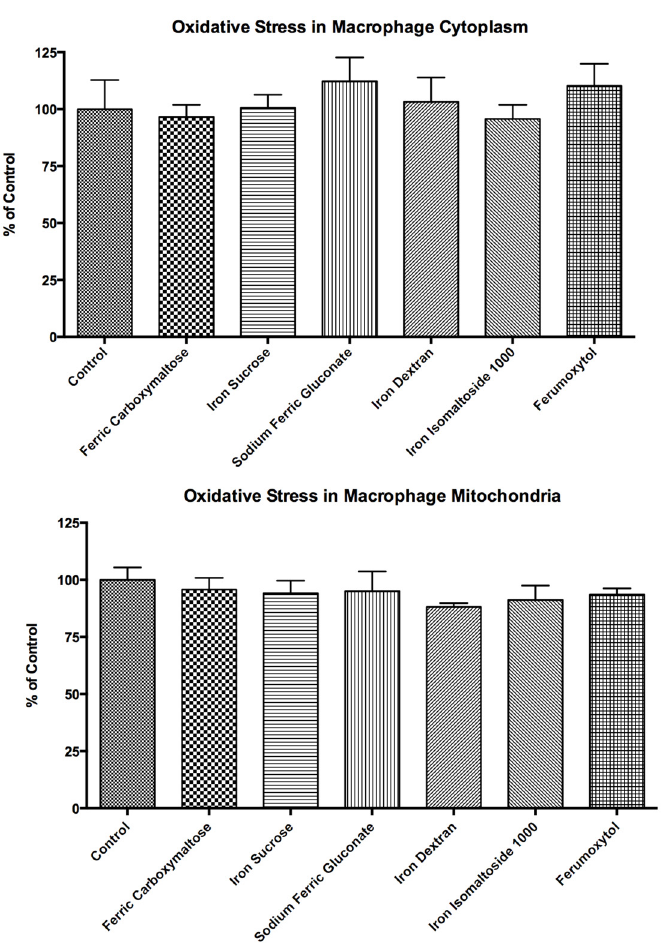
Fig 8. Oxidative stress within cytoplasm and mitochondria of rat macrophages. Rat peritoneal macrophages were obtained by peritoneal lavage. The cells were exposed to 0.1 mg/ml of elemental iron for each of the iron formulations for 24 hours. After 24 hours, the cells with iron were incubated with CellROX Deep Red Reagent (top figure, A) or CellROX Green Reagent (bottom figure, B) for thirty minutes. Following incubation, the cells were washed with PBS. Fluorescence was quantified on a fluorescent plate reader at excitation/emission wavelengths of 640/665 nm for cytoplasm study or 485/520 nm for mitochondria. All data shown are means ± SEM of three independent observations in separate cell culture wells. The data shows there were no significant changes in oxidative stress following the addition of the iron compounds compared to the control